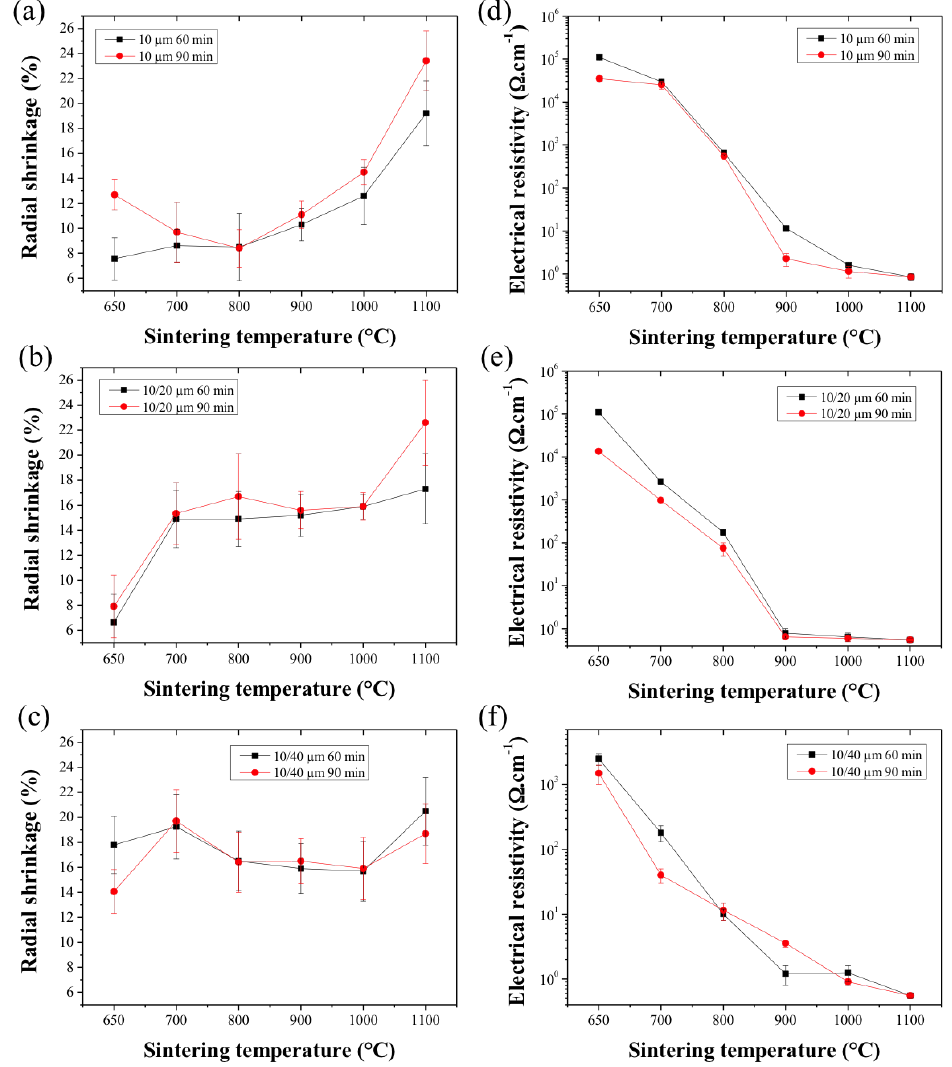
Figure 6. Radial shrinkage from green to sintered HFs as a function of the sintering time and temperature. ( a ): SS 10 HFs, ( b ): SS 10/20 HFs and ( c ): SS 10/44 HFs. ( d – f ) are the electrical resistance of the